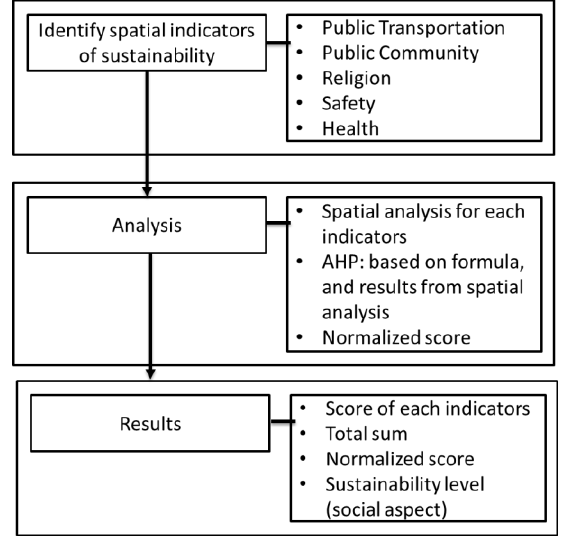
Figure 1: Study Approach